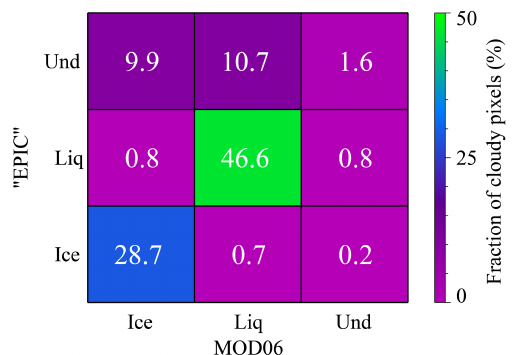
Figure 3. Monthly cloud thermodynamic phase skill table, from April 2005 Aqua MODIS, comparing the proxy EPIC algorithm results to those of MOD06. Although EPIC’s lack of information content for phase will likely yield a larger fraction of undetermined phase results, an algorithm using only cloud temperature thresh- olds nevertheless agrees with the multiple-test MOD06 algorithm for roughly 77% of the global daytime cloudy pixels during this month.